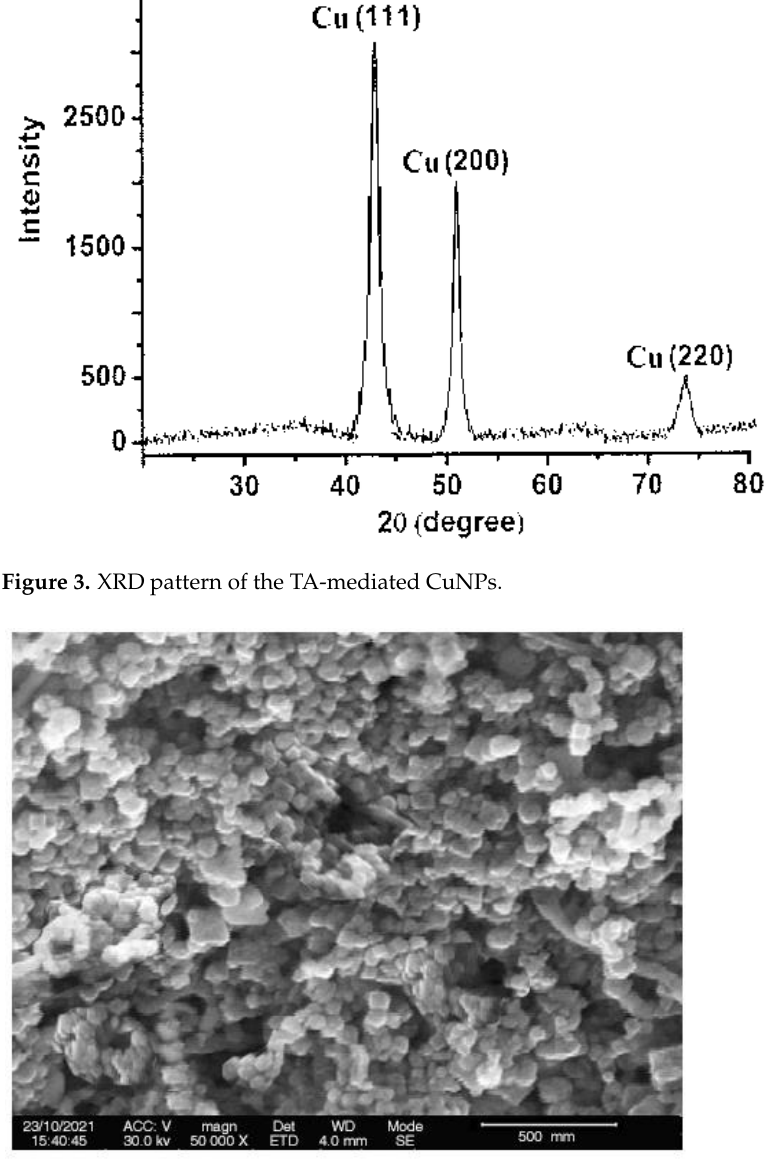
Figure 3. XRD pattern of the TA-mediated CuNPs.